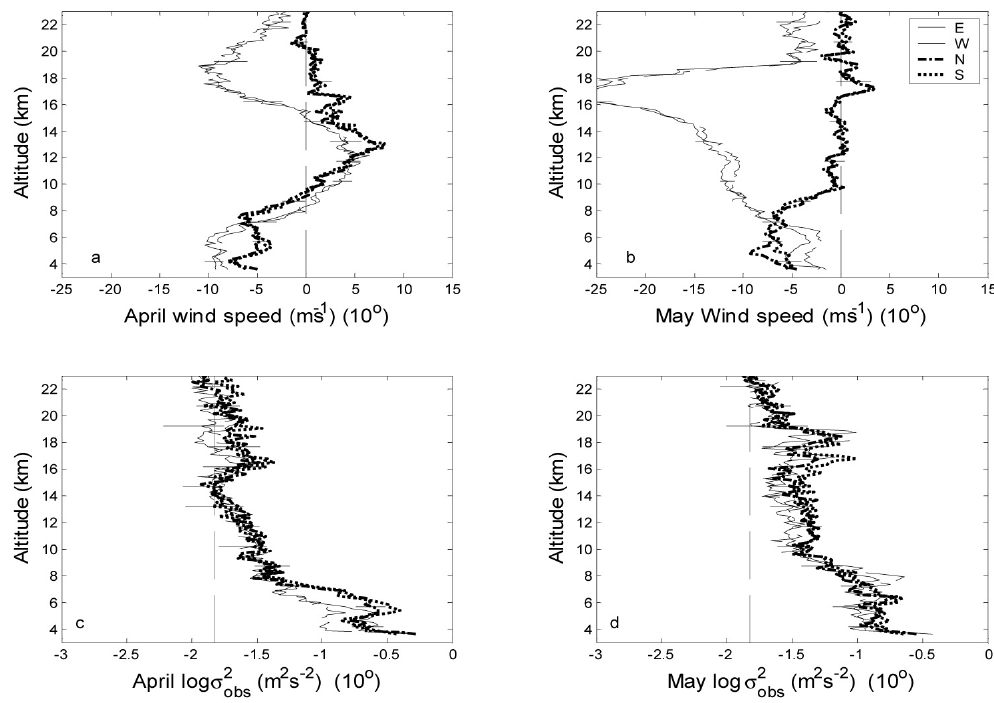
Fig. 2. Median (upper) winds and (lower) observed spectral widths over all observations taken at 10 ◦ zenith angle during (left) April and √ (right) May. Bars extending ± 2 σ/ N o are entered at representative heights along the E and N curves. Dashed vertical lines in the lower panels show the minimum spectral resolution for Doppler half-width.